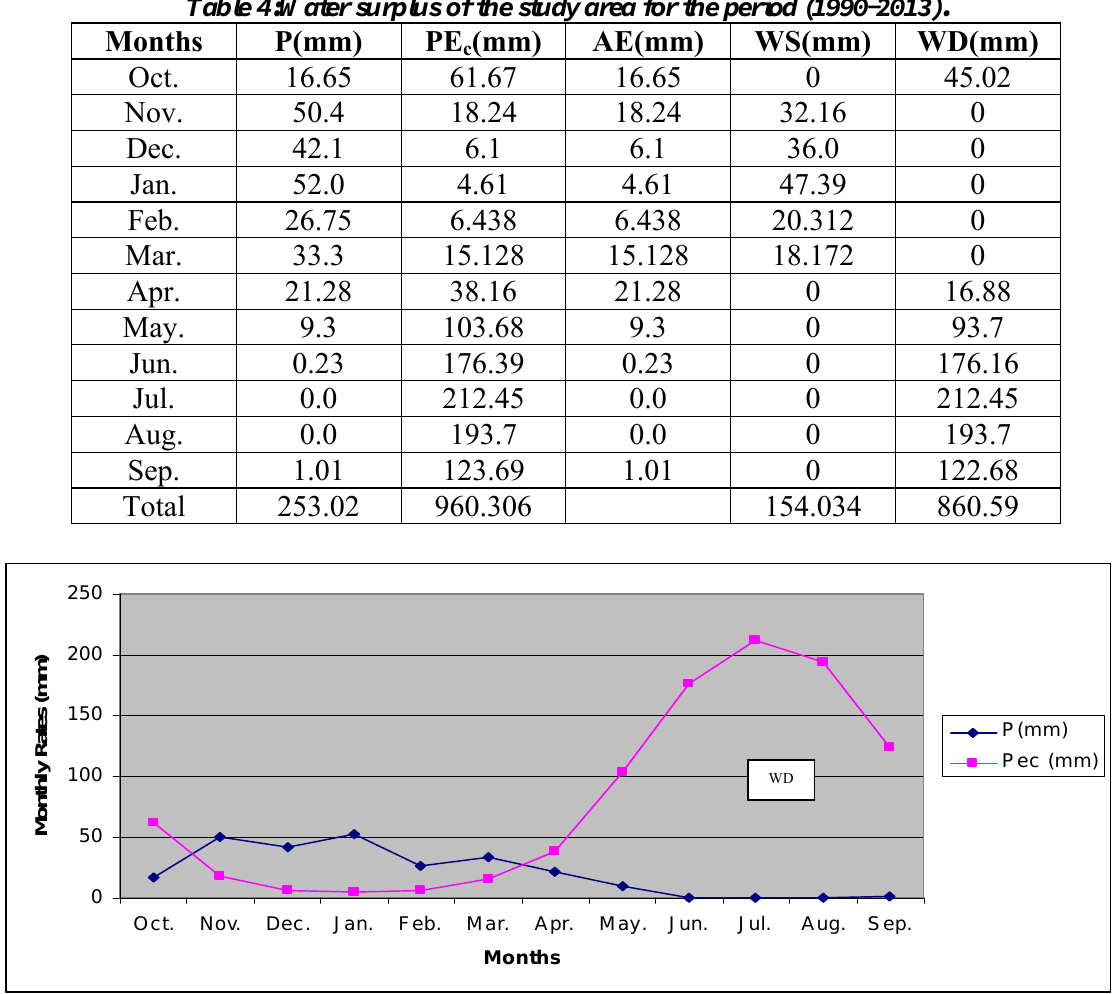
Fig.(2) : The relationship between monthly averages of rainfall (P)and corrected potential evapotranspiration, shows water surplus(WS) and the water deficit (WD)for the study area.